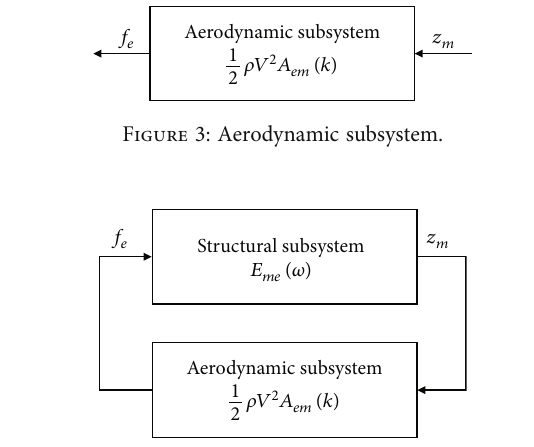
Figure 4: Low-order MIMO aeroelastic system.